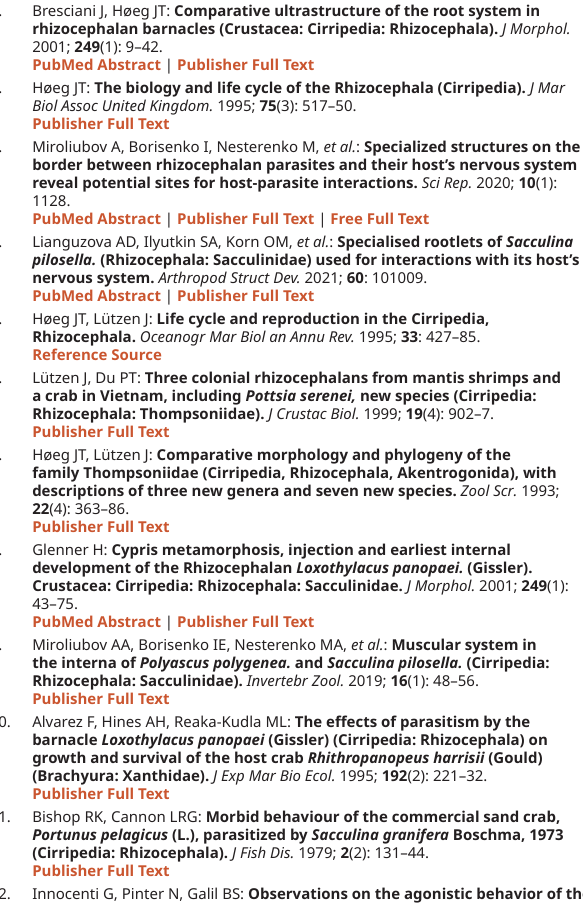
Figshare: Figure S2. Phylogenetic relationships between the crustacean species based on orthologs analysis results, https://doi.